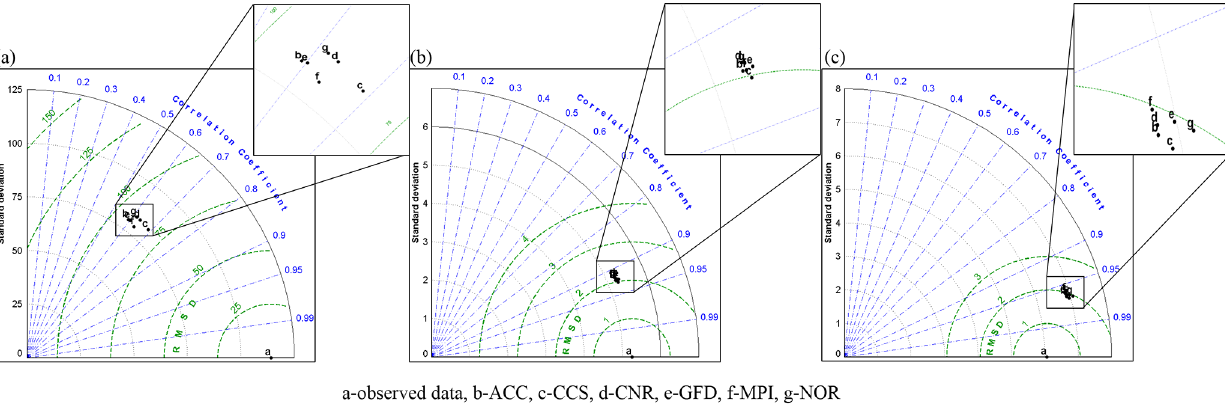
Figure 2. Taylor diagram for (a) rainfall (mm), (b) T max ( ◦ C) and (c) T min ( ◦ C) for the upstream